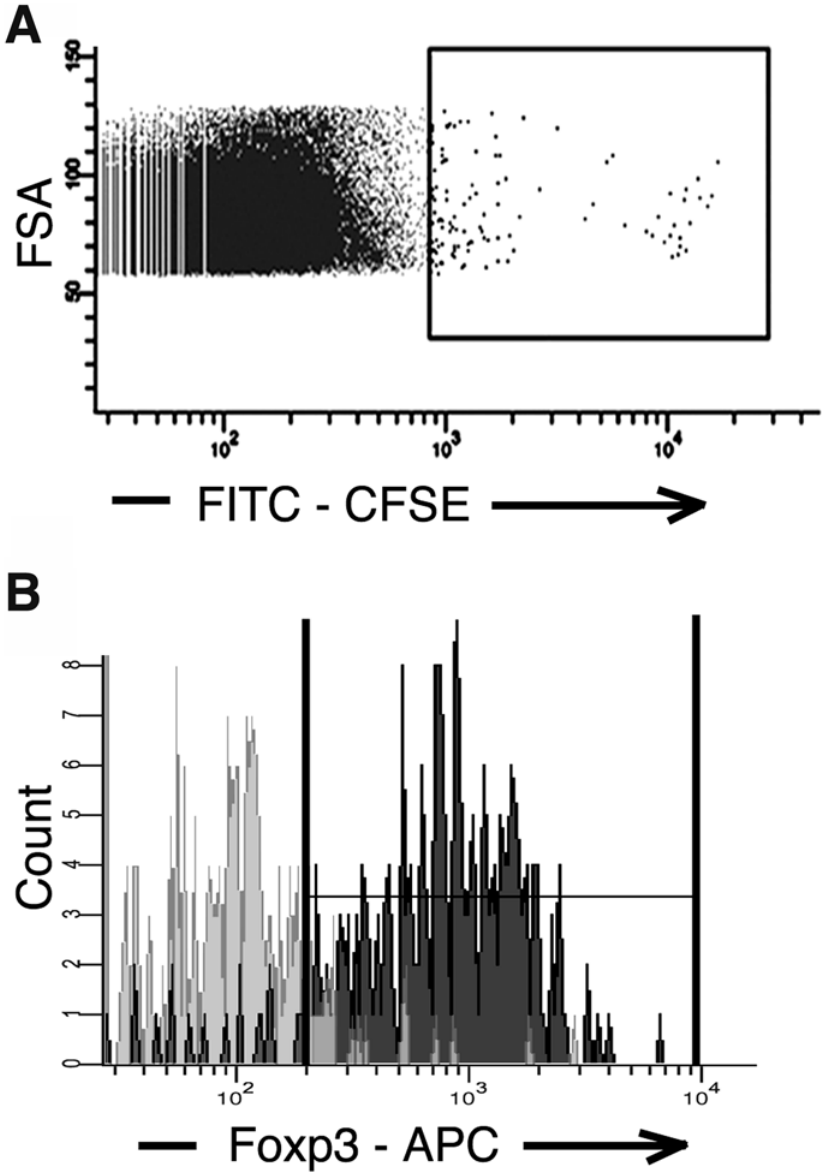
Figure 4. Invivo survival and proliferation of expanded T regs detected 30 days following adoptive transfer. A) A small population of CFSE + labeled cells could be detected and FACS sorted at 30 days from a pool of lymphocyte isolation from lymphatic, splenic, salivary gland, lung, liver and kidney tissue (FITC bright sort gate shown containing , 0.2% of CD4 + T cells). B) Characteristic Foxp3 staining of sorted FITC bright cells demonstrating . 90% of these cells are Foxp3 + (dark grey histogram), consistent with these cells being derived from the adoptively transferred CFSE labeled, Foxp3 + T regs and not FACS artifact (isotype control shown in light grey histogram, 3 mice cohort).